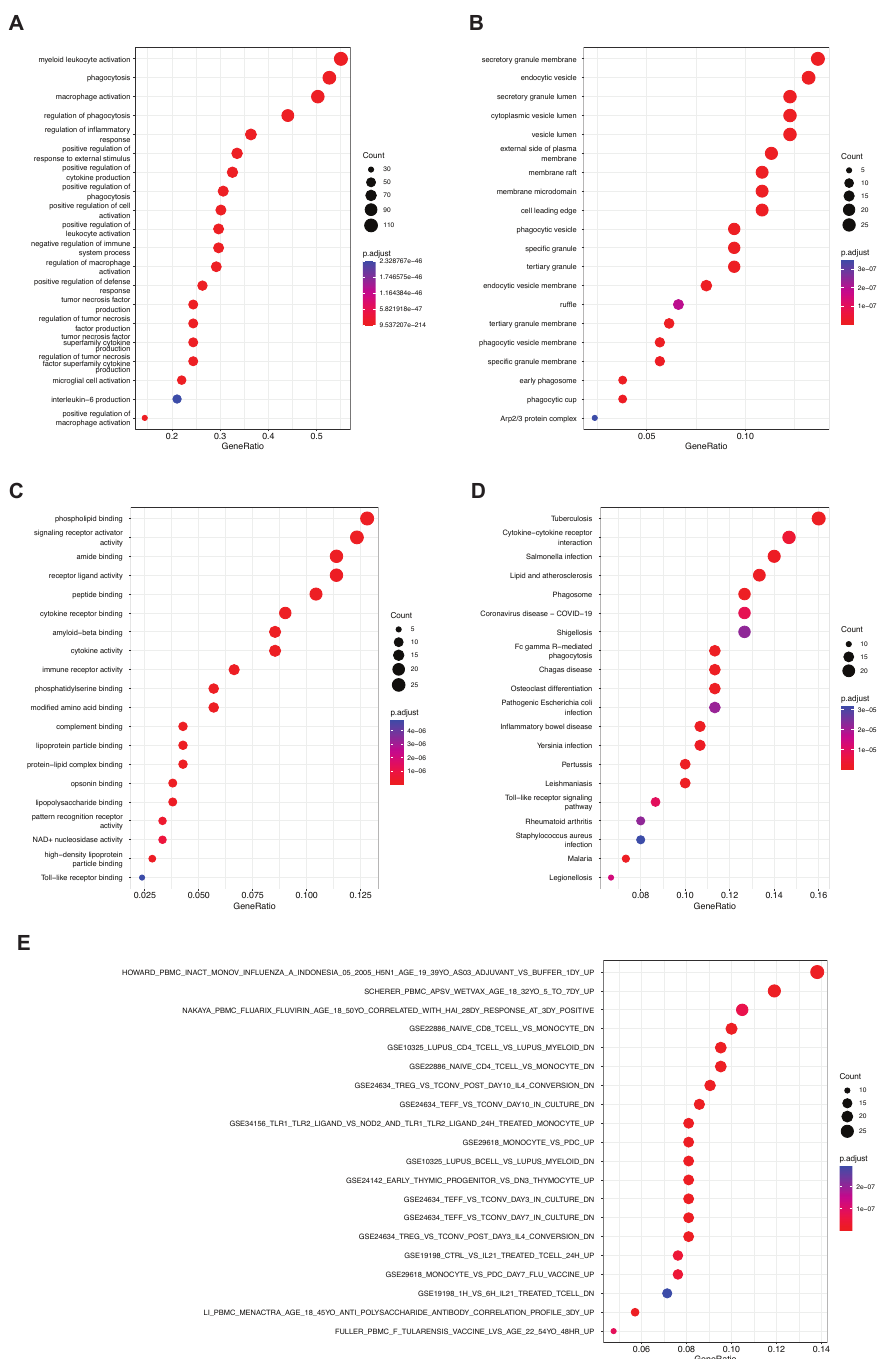
Figure 2. Functional enrichment analysis of phagocytic factors. ( A ) GOBP, gene ontology biological process; ( B ) GOCC, gene ontology cellular component; ( C ) GOMF, gene ontology molecular function; ( D ) KEGG, Kyoto Encyclopedia of Genes and Genomes; ( E ): set of immune-related